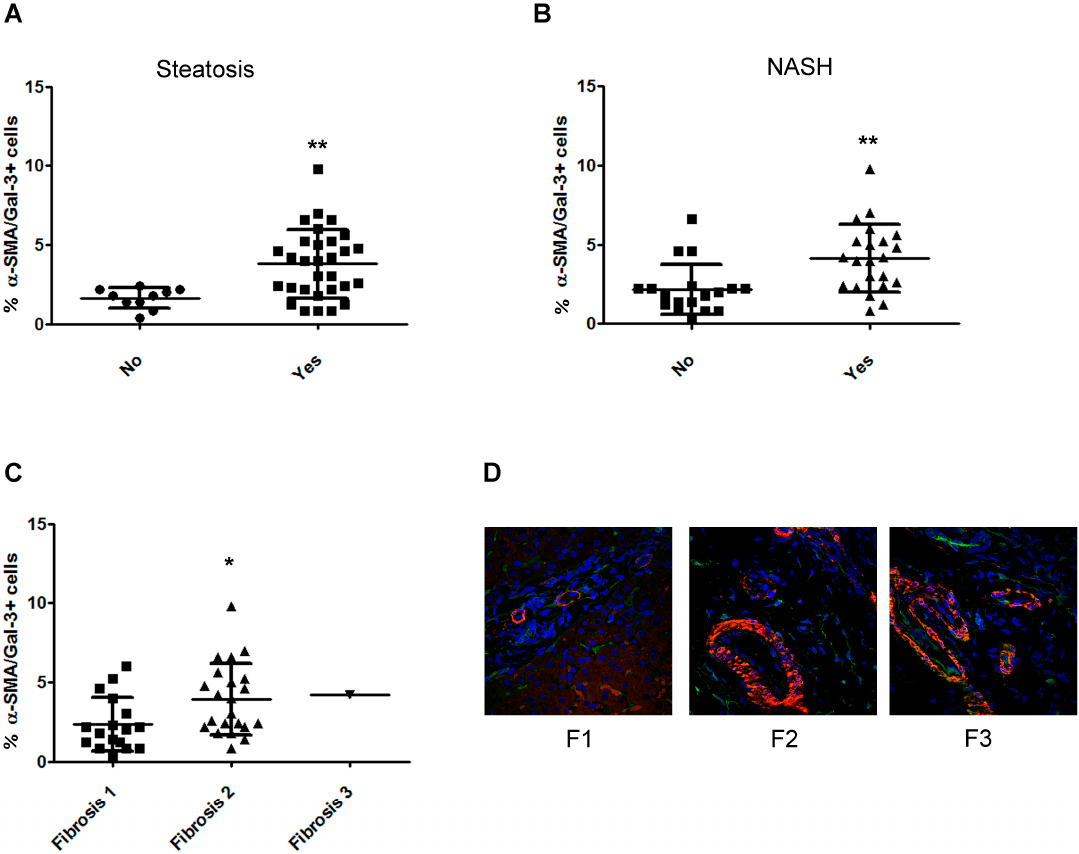
Figure 5. Analysis of the number of hepatic α -SMA / Gal-3 + cells in children with NAFLD associated with severity of fibrosis. ( A – C ) Percentage of α -SMA / Gal-3 + cells in the liver tissue from children with NAFLD correlated with degrees of steatosis ( A ), NASH ( B ), and the severity of fibrosis ( C ). ( D ) Representative image of immunofluorescence of α -SMA expression (red) and Gal-3 expression (green) in liver tissues from children with NAFLD with fibrosis scores of F1, F2, and F3. Magnification 60 × . Nuclei were counteracted with Hoechst staining (blue). ** p < 0.01; * p < 0.05.